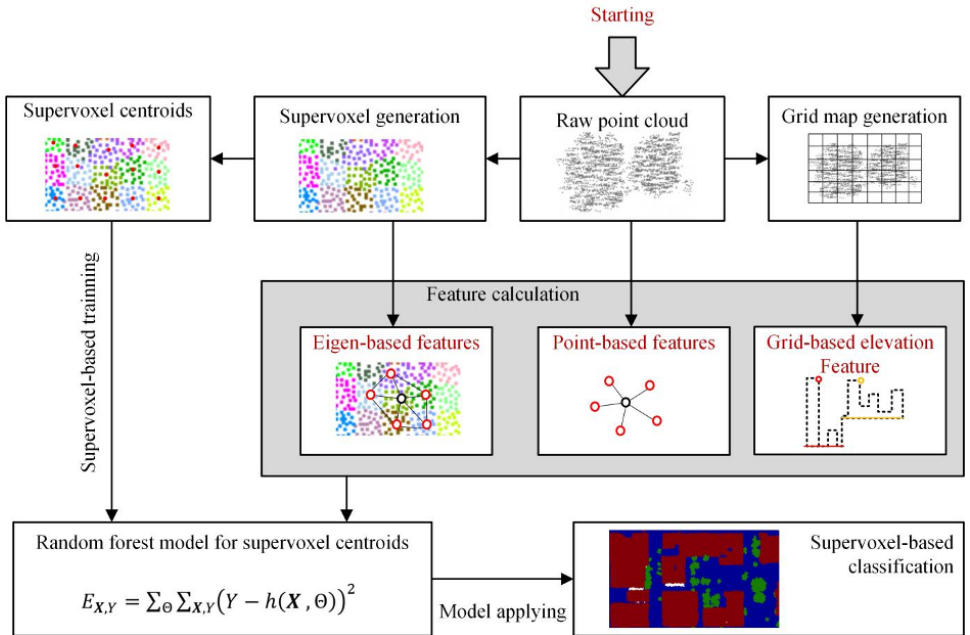
Figure 1. Supervoxel-based random forests framework for point cloud classification. The equation of the random forest model located at the bottom-left refers to the least squares method applied in the model to predict unlabeled points, in which Y represents the label, X represents an individual centroid point, and Θ represents the coefficient